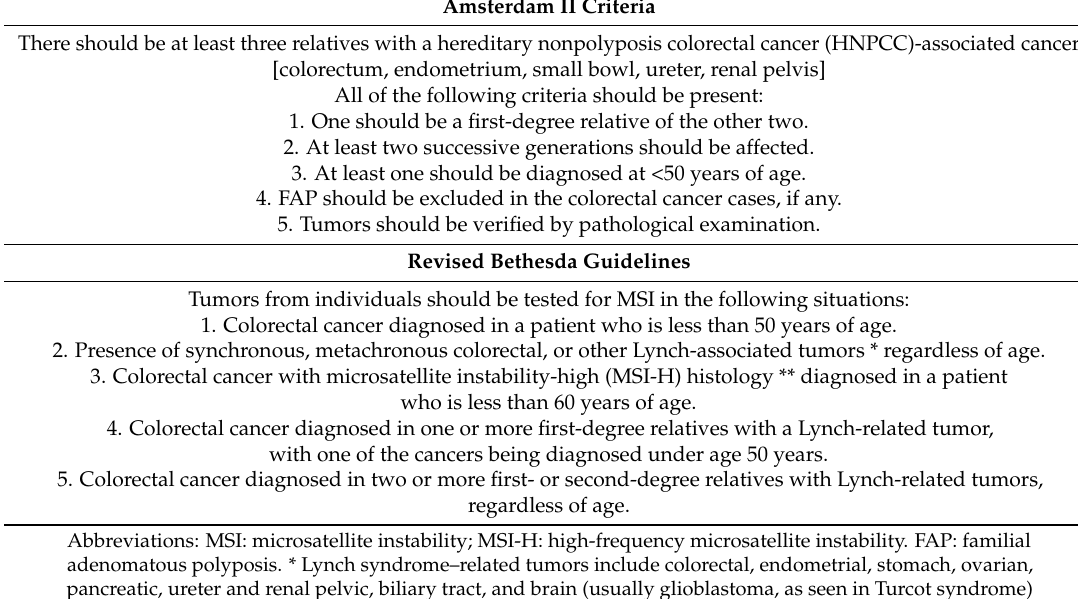
Figure 3. Family tree of the patient with MLH1 epimutation. The patient had familial accumulation of Lynch ‐ associated cancers, met the revised Bethesda guidelines, and met the Amsterdam II criteria.